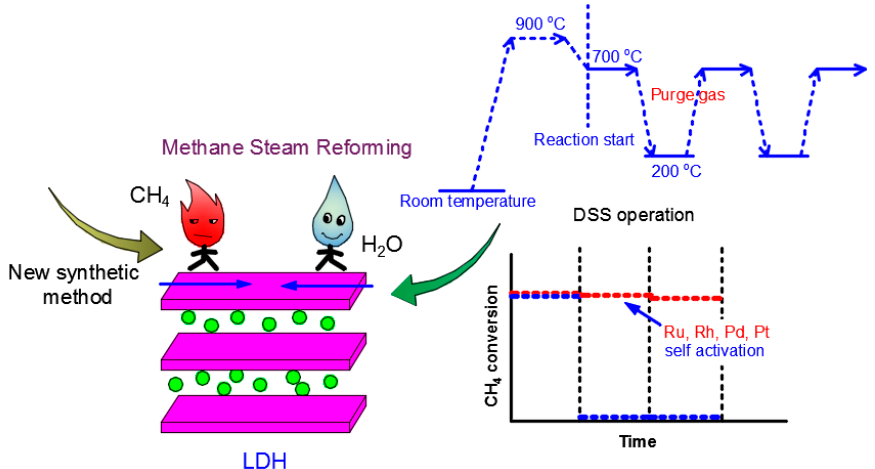
Figure 8. The application of LDHs in steam reforming of methane.